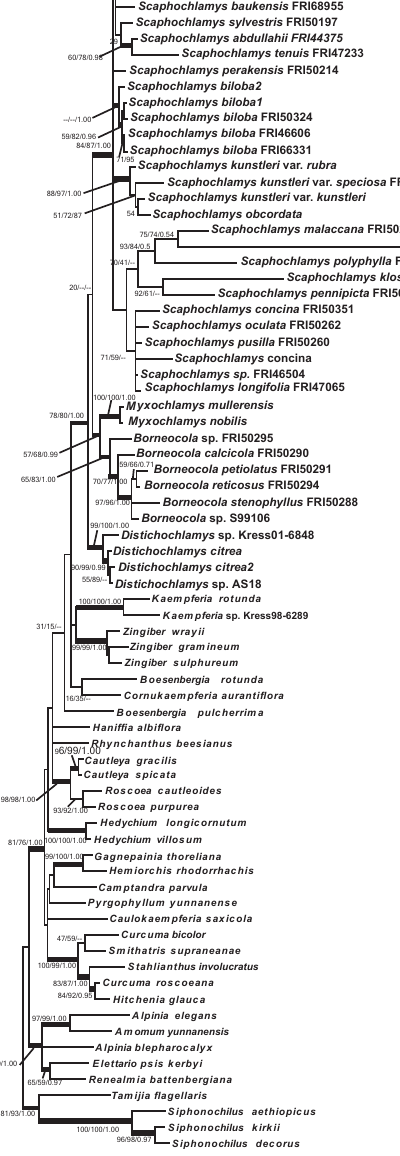
Figure 1. Molecular phylogenetic analysis of the ITS sequence data by the Maximum Likelihood method. Numbers above branches indicate bootstrap values of ML and MP and posterior probability of Bayesian